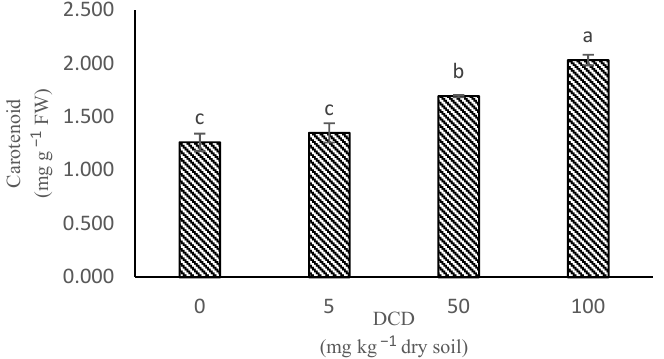
Figure 5. The main effect of dicyanodiamide in leaves of lettuce on total chlorophyll content. (The means refer to four repetitions ± SD. Different letters for each parameter indicate significant differ- ences assessed ( p < 0.05).)